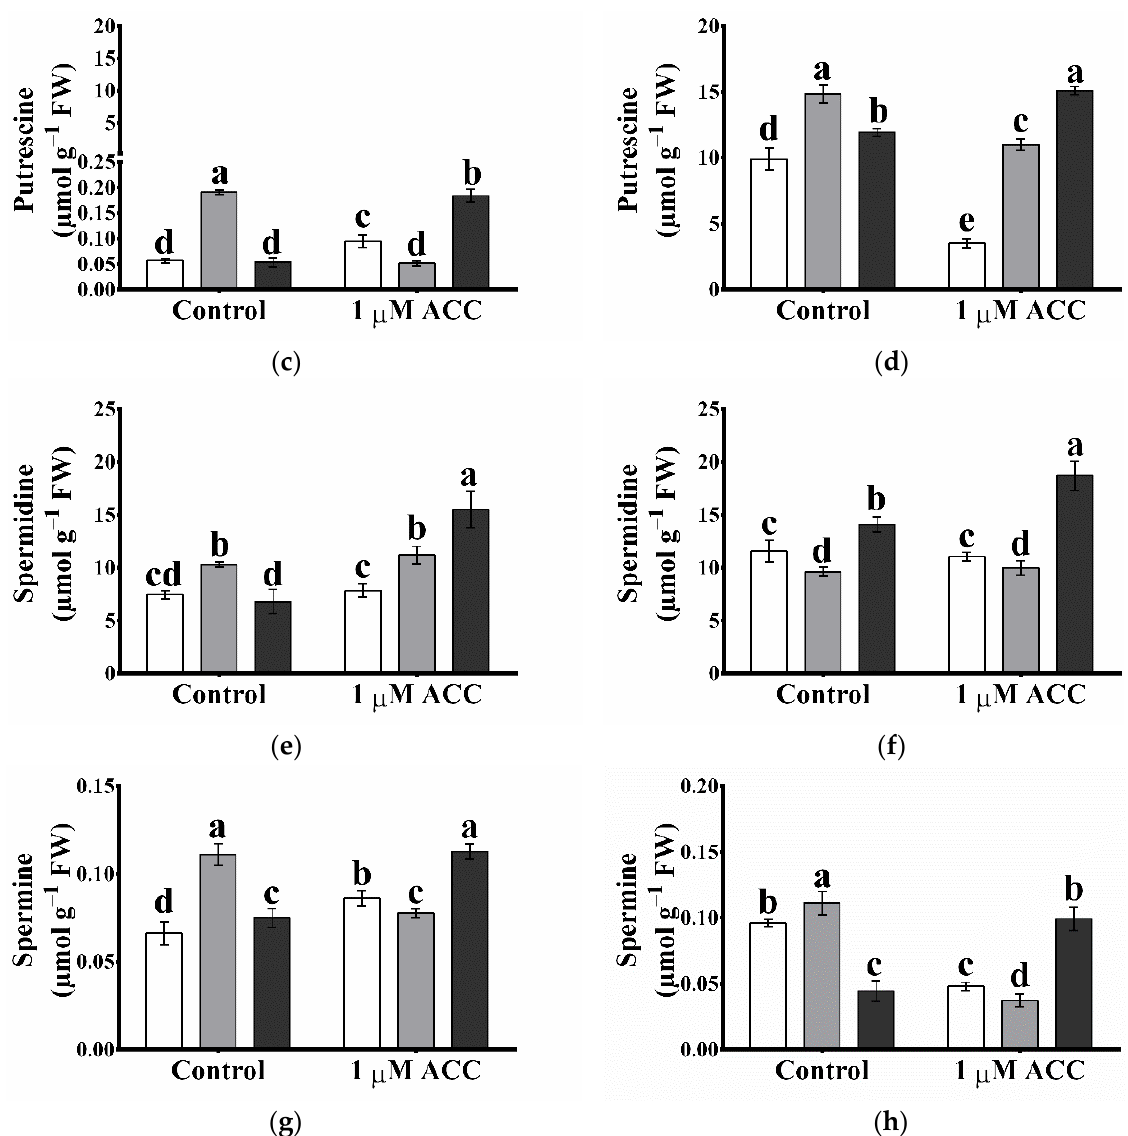
Figure 7. Effect of one-day 1 µ M ACC treatment on free polyamine accumulation ( a , b ) (Put—putrescine ( c , d ), Spd—spermidine ( e , f ) and Spm—spermine ( g , h )) in shoots ( a , c , e , g ) and roots ( b , d , f , h ) of Col-0, Atgpxl5-1 insertional mutant ( Atgpxl5 ) and AtGPXL5-overexpressing (OX-AtGPXL5) plants. The data are presented by mean values ± SD, n = 3. Data were analysed using one-way ANOVA followed by Duncan’s test. Different letters represent data considered statistically significant at p ≤ 0.05.